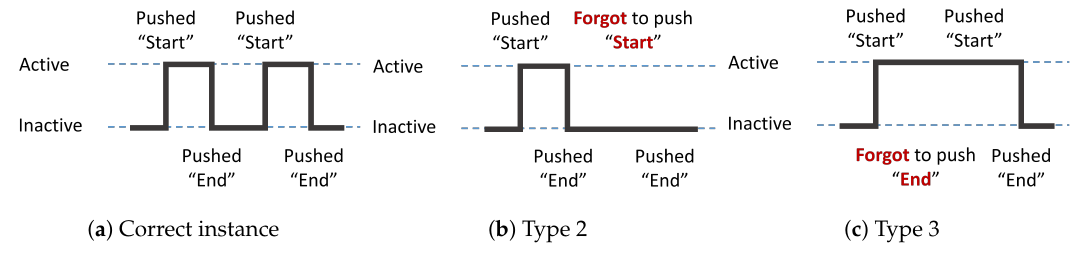
Figure 8. Imputation examples.